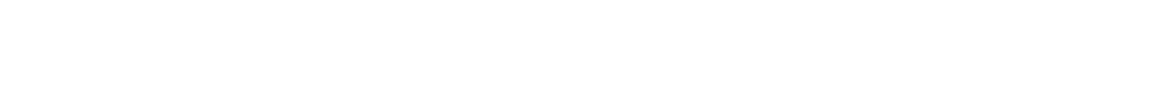
FIGURE 6 | (A) Chrysin treatment at 5, 10, and 15 µM – 48 h decreased the global DNA methylation in a dose-dependent manner. (B) Chrysin treatment of HeLa cells at 10 and 15 µM for 48 h demonstrated profound decrease in percent methylation in 5 ′ CpG promoter regions of TSGs as compared to the DMSO controls in a dose-dependent manner.